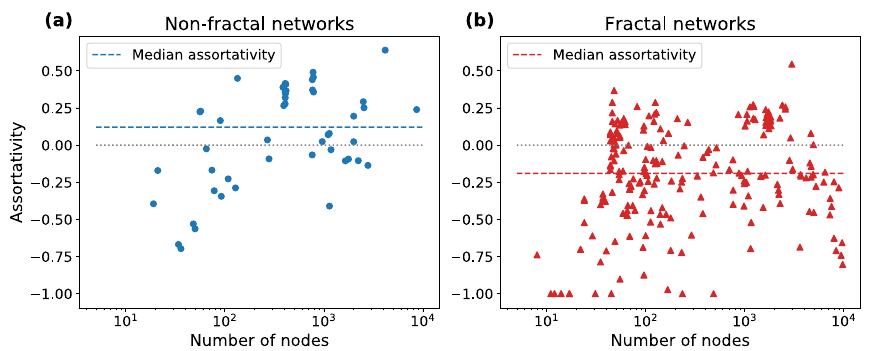
Fig. 14 Assortativity of real networks plotted against the number of nodes on a semi‑log scale. Subfigure a shows the non‑fractal, subfigure b the fractal networks. The grey dotted reference line shows Assortativity 0. The difference in the distribution of the assortativity of the fractal and non‑fractal networks is statistically